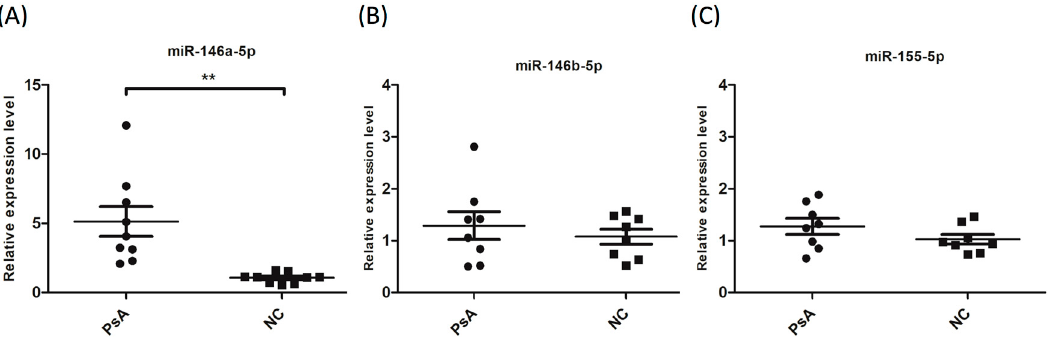
Figure 1. miR146a-5p expression is higher in CD14 + monocytes from PsA patients compared to normal controls (NCs). RNA samples were extracted from peripheral CD14 + monocytes of PsA patients and NCs. The expression levels of ( A ) miR-146a-5p, ( B ) miR-146b-5p, and ( C ) miR-155-5p were measured in NCs ( n = 10) and PsA patients ( n = 10) by qRT-PCR. Patients with PsA showed increased expression of miR-146a-5p in CD14 + monocytes. ** p < 0.001.